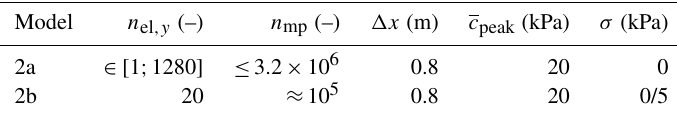
Table 5. Geometrical and material properties for Models 2a and b. The correlation length vector is λ = (λ x ,λ y ,λ z ) = ( 2 . 5 , 2 . 5 , 2 . 5 ) m for both Gaussian and exponential isotropic covariance functions. The grid spacing is always constant in Models 2a and b, i.e. (cid:49)z = (cid:49)y = (cid:49)x = 0 .